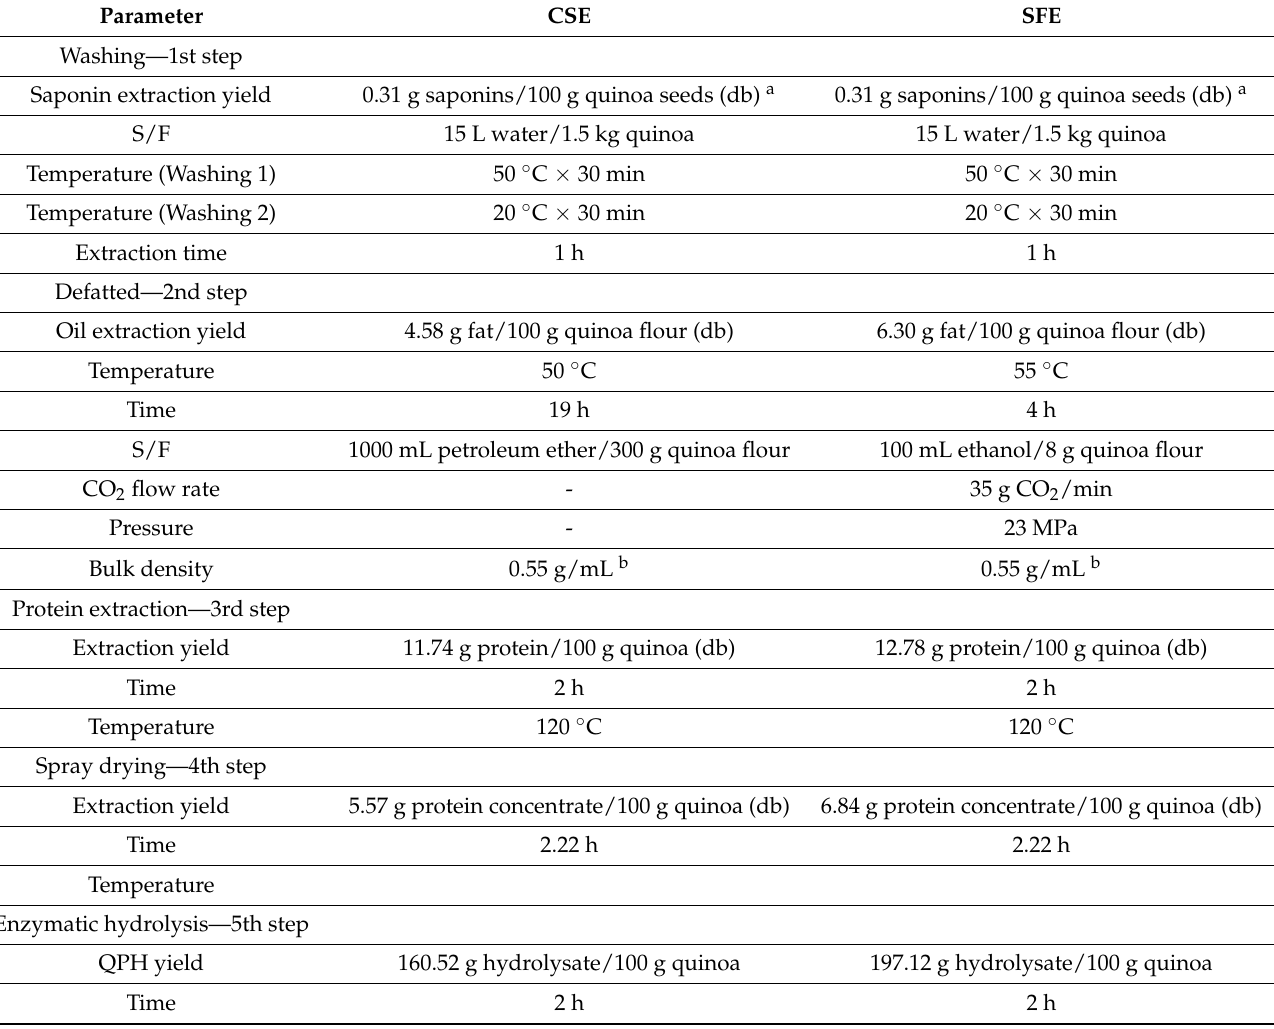
Table 1. Experimental data used to simulate the production of QPH by supercritical fluids’ extraction (SFE) and conventional solvent extraction